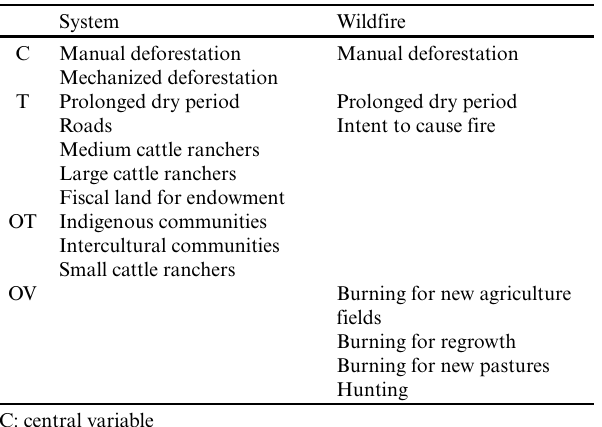
Table 4 . Sensitivity analysis on the augmented fuzzy cognitive map. Variables with the highest effect on the system as a whole, and on wildfire occurrence in